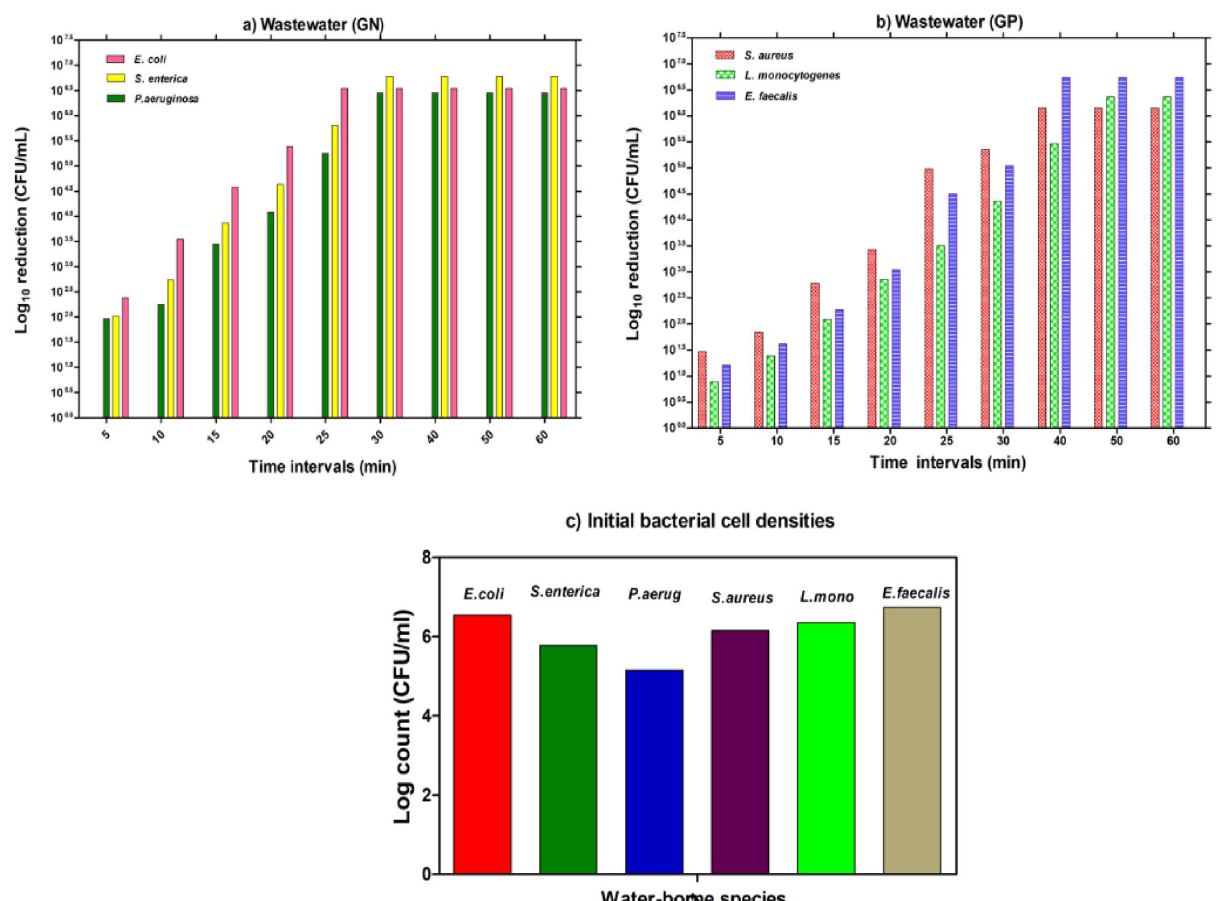
Figure 14. Disinfection of wastewater samples using 100 mg/L of SMZC-0.7Ni during various time